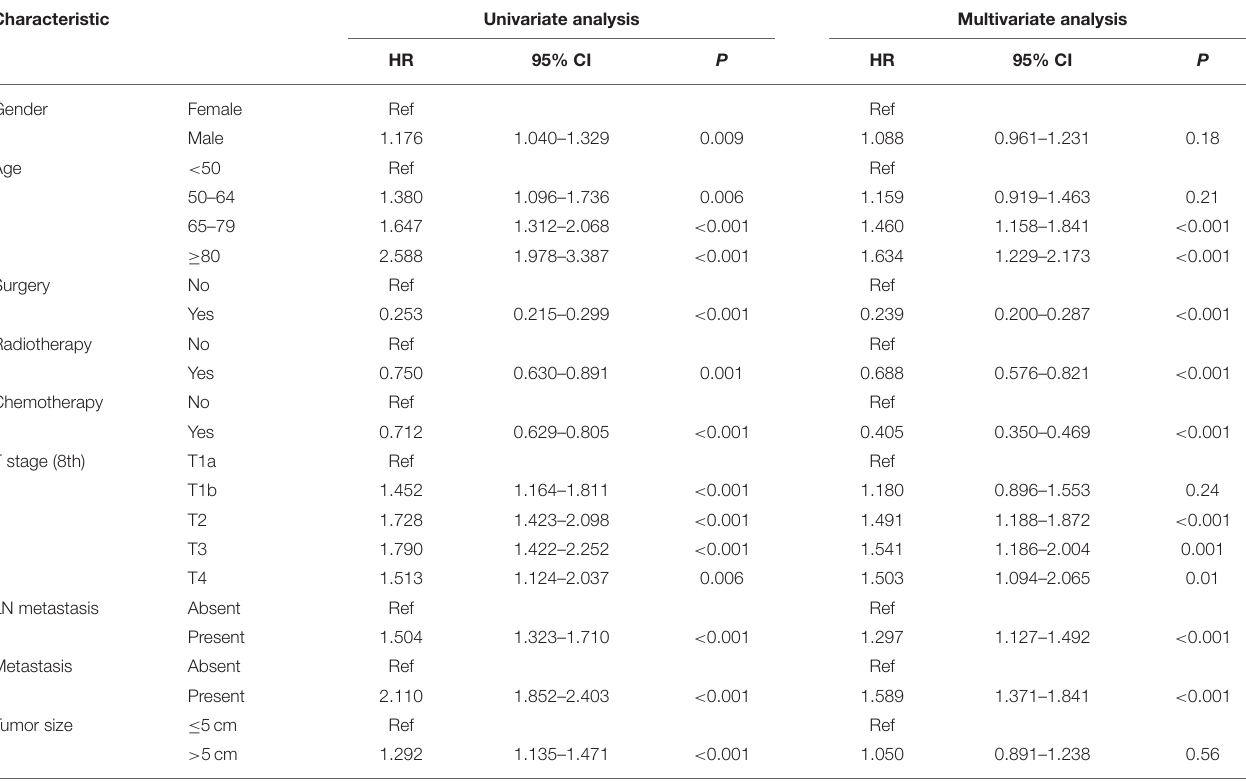
TABLE 2 | Univariate and multivariate analyses for OS in patients with ICC.